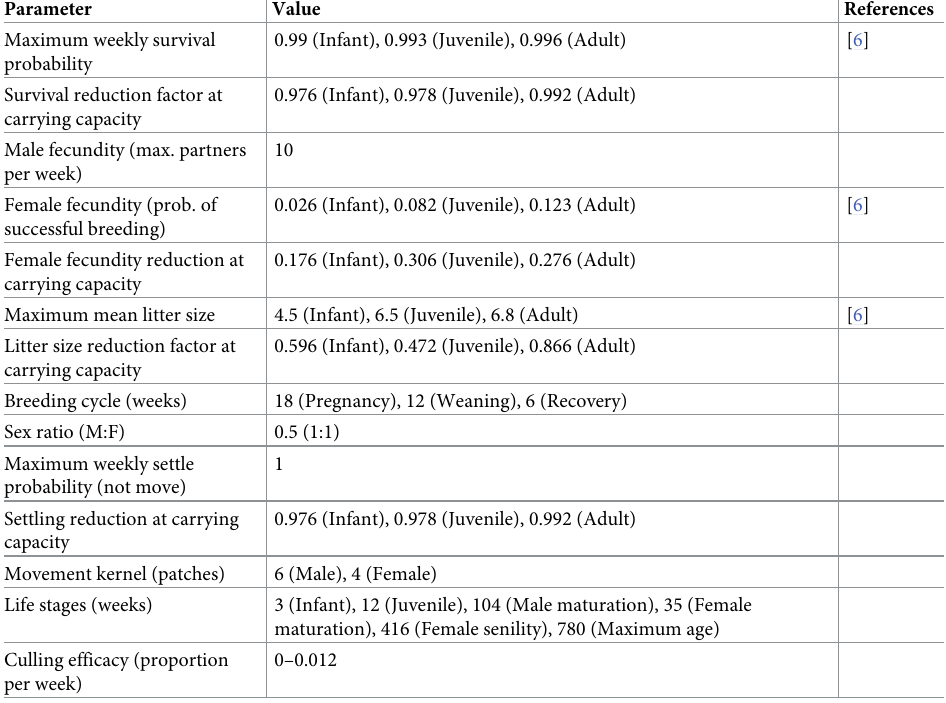
Table 1. Population parameter values used in the